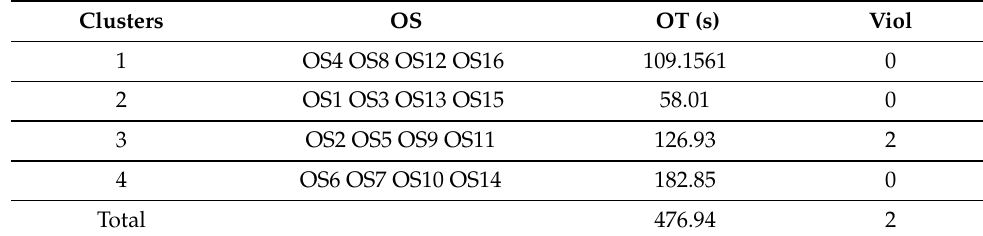
Table 6. Clustering results with PCA.